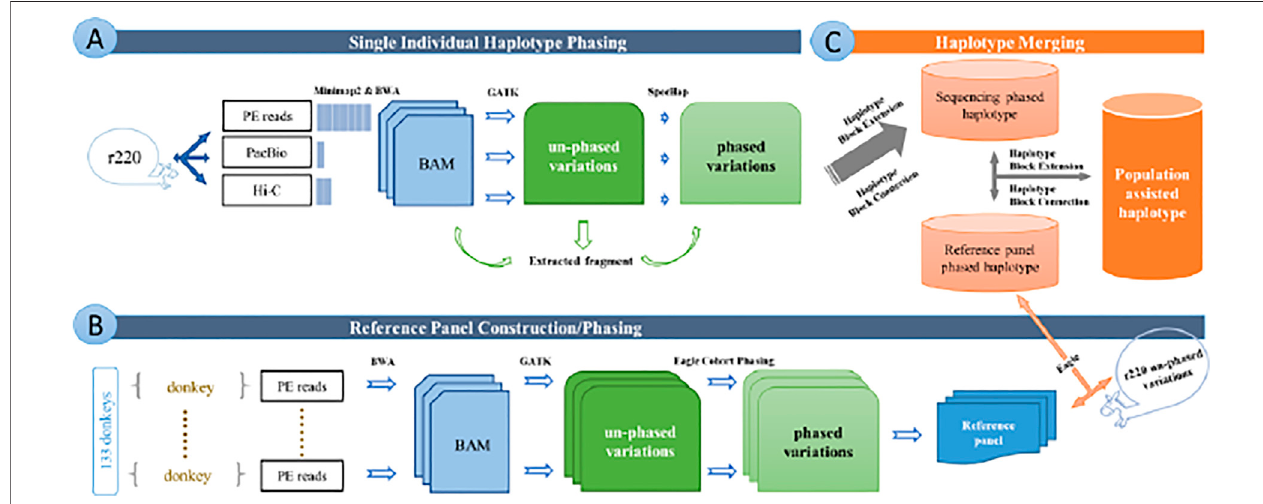
FIGURE 1 | Overview of the whole pipeline of data editing and analyzing. (A) Pipeline of single individual haplotype phasing. (B) Pipeline of reference panel construction and cohort phasing. (C) Pipeline of haplotype merging. Figures show the all working procedure for chromosome-level haplotype construction from sequencing